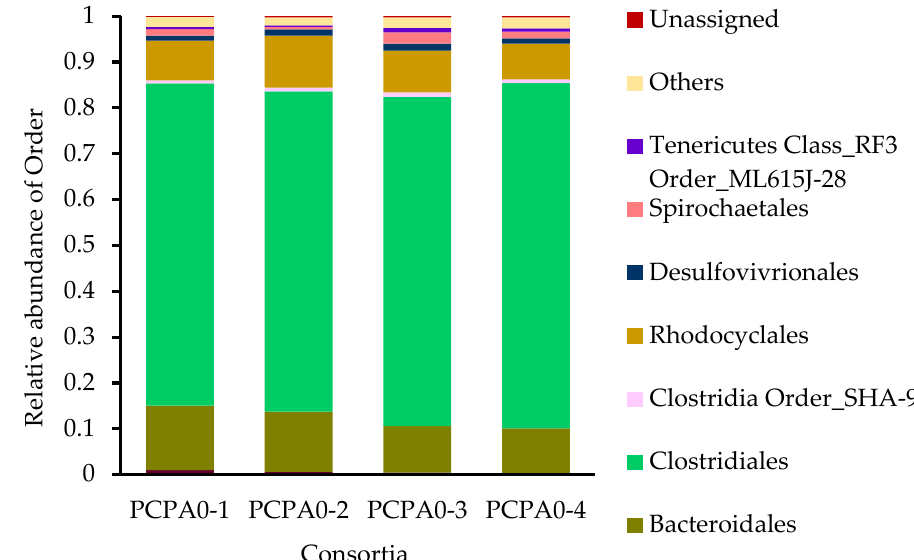
Figure 4. Community structure of consortium PCPA0 based on 16S rRNA gene sequencing. The data shows the community structures of four replicates of the consortium PCPA0, individually. “Others” denotes the populations less than 0.5% abundance. “Unassigned” represents the genes that were not assigned to any taxonomic position by blast sequencing.